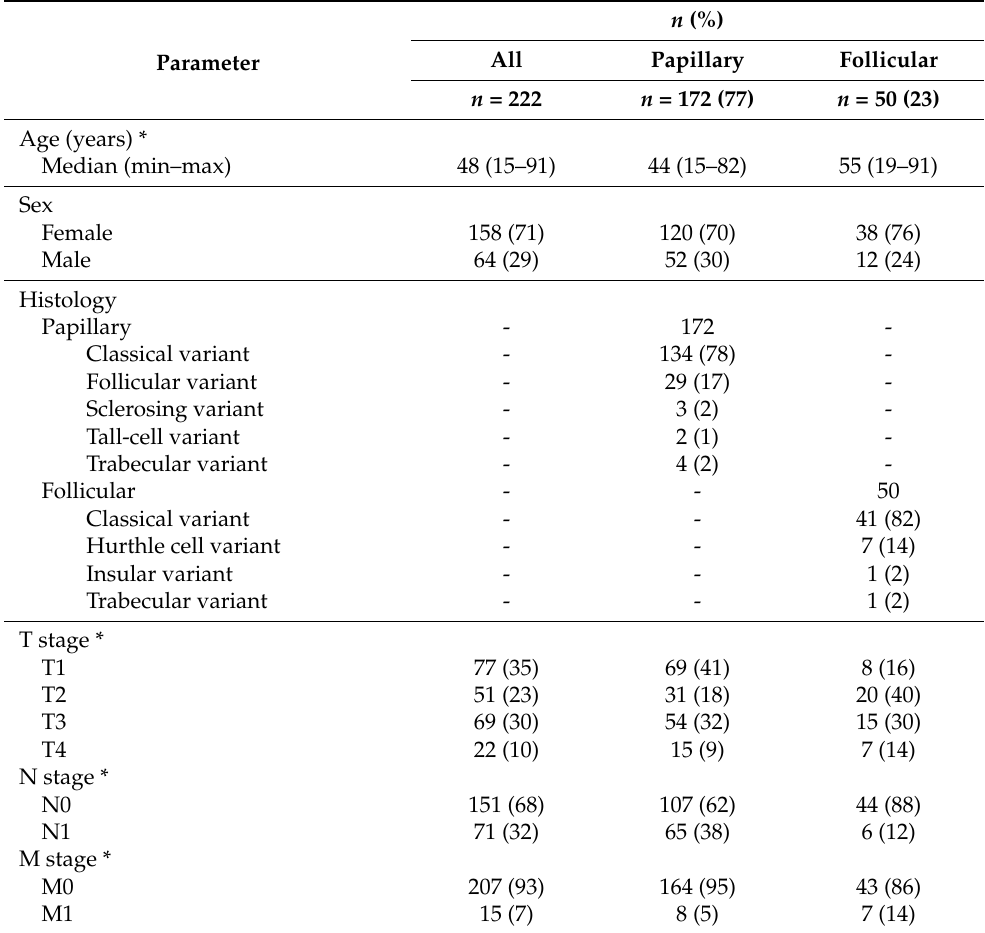
Table 1. Patients’ baseline characteristics ( n =